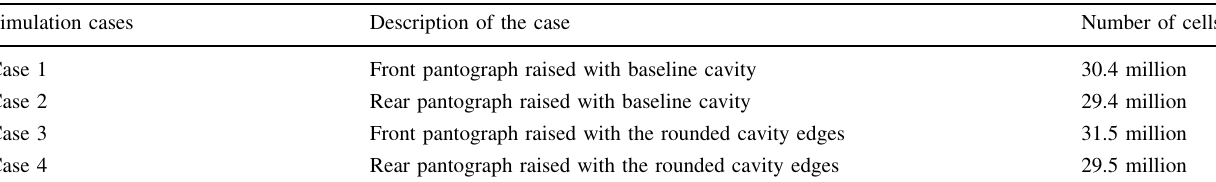
Table 5 The grid for each cases